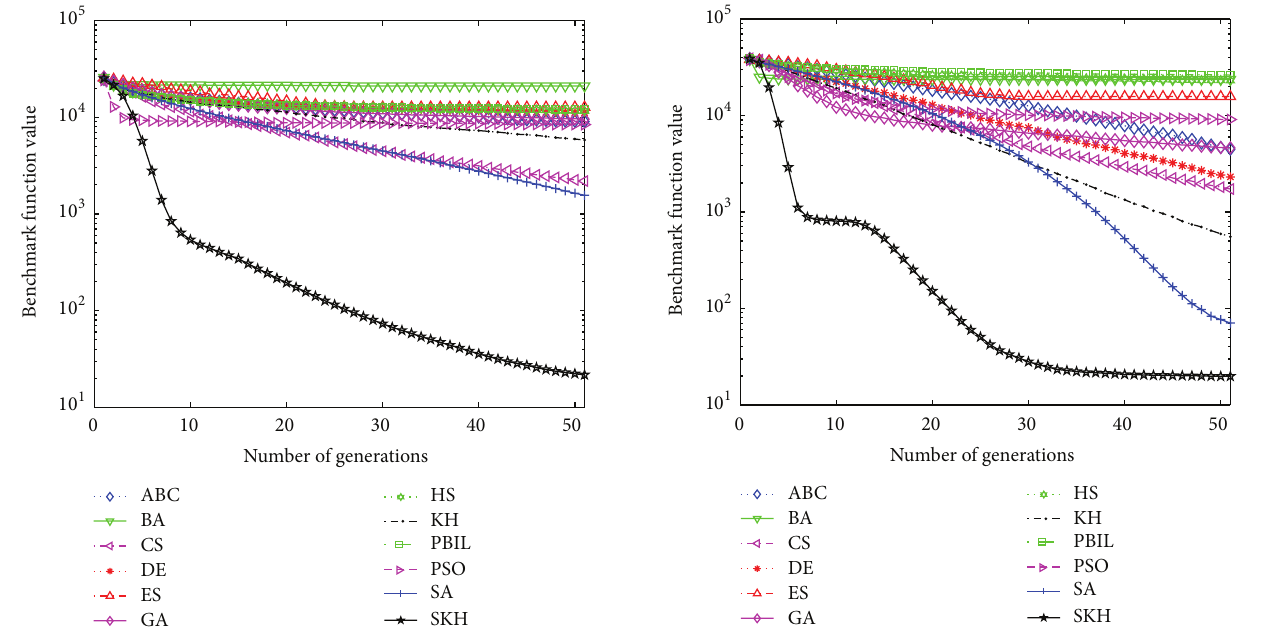
Figure 5: Comparison of the performance of the different methods for the F10.